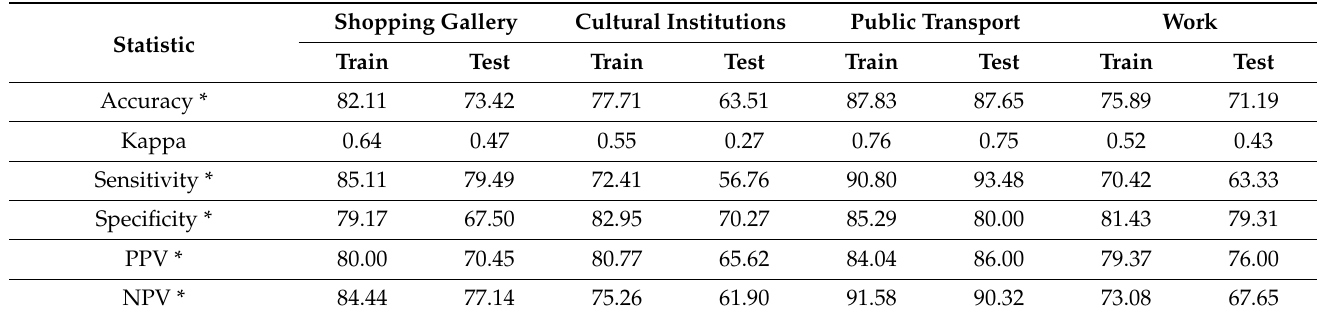
Table 3. Evaluation of built predictive models on training and test datasets.